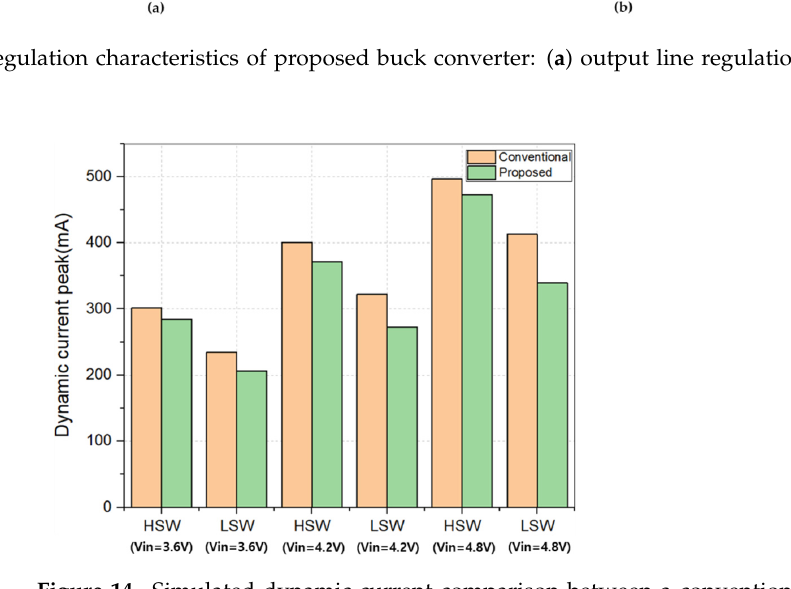
Figure 14. Simulated dynamic current comparison between a conventional gate driver and the proposed non-overlapping gate driver.